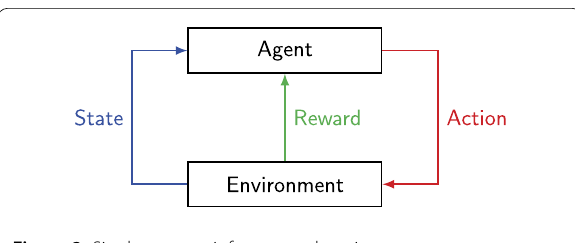
Figure 2 Single-agent reinforcement